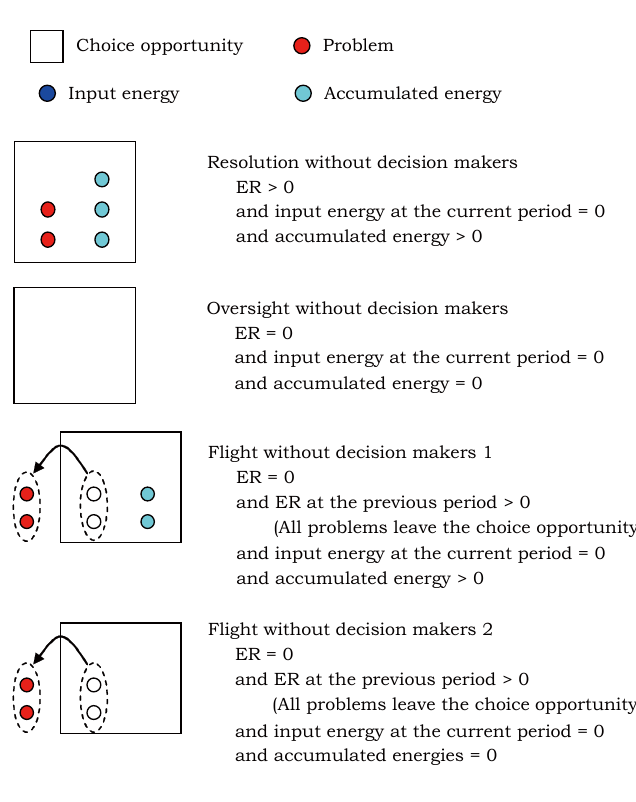
Figure 4. Decision making without decision